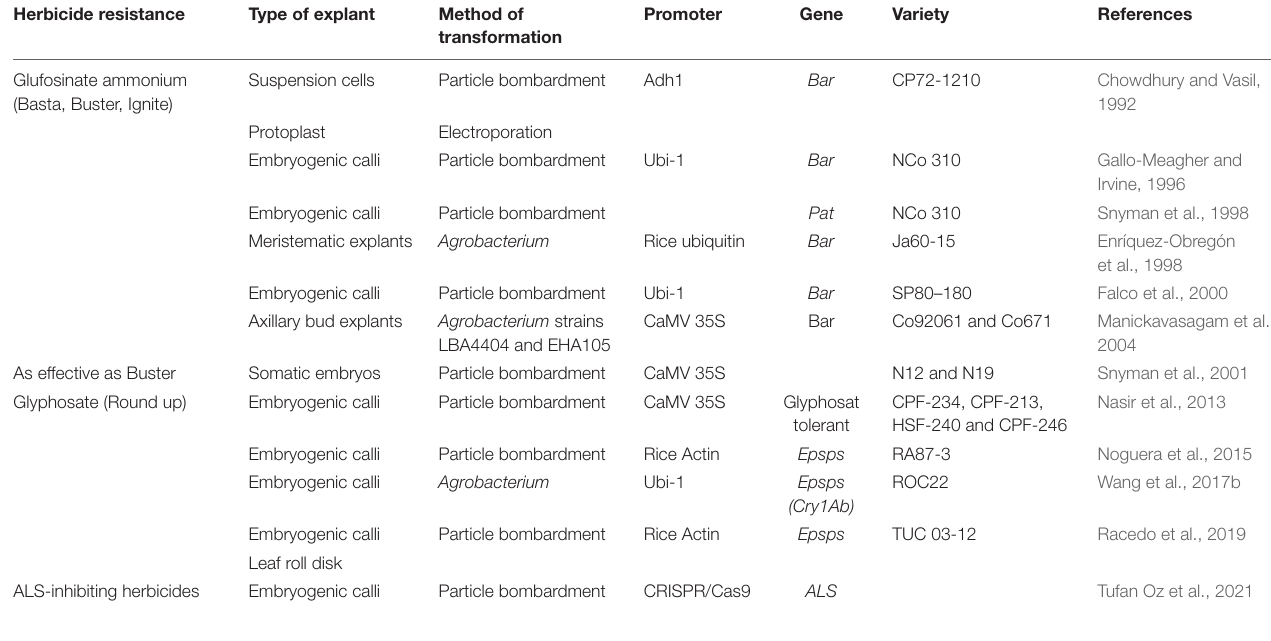
TABLE 4 | Reports of herbicide resistant sugarcane transgenic